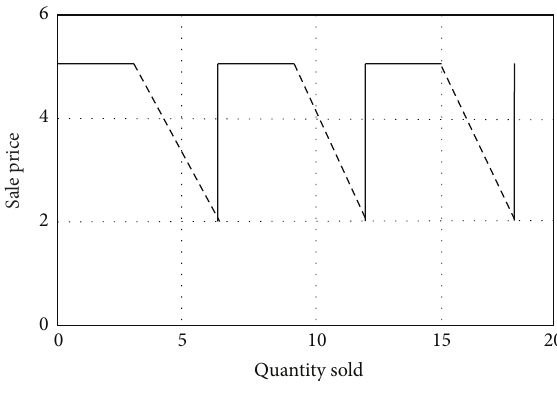
Figure 5: Graphical representation of relationship (3) in